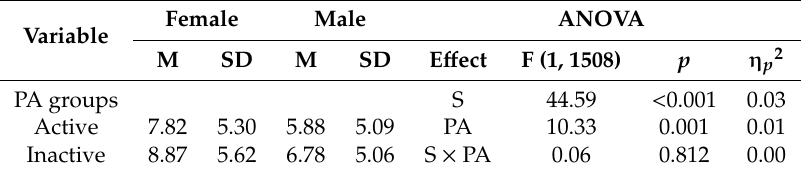
Table 5. Means, standard deviations, and two-way ANOVA statistics for depression.